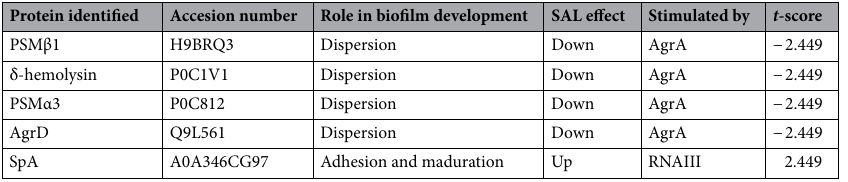
Table 3. S. aureus proteins affected by SAL. Proteins identified by MALDI-TOF–MS. t- score values < − 2.015 or > 2.015 are